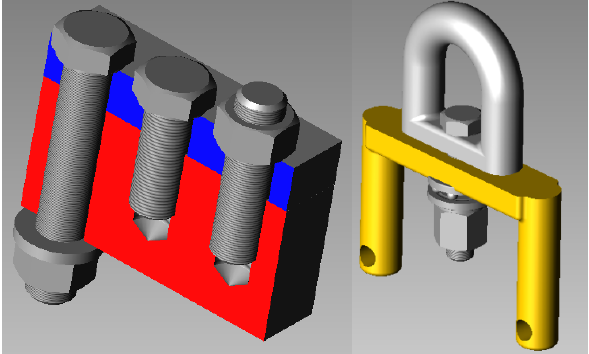
Fig. 1. Models of the